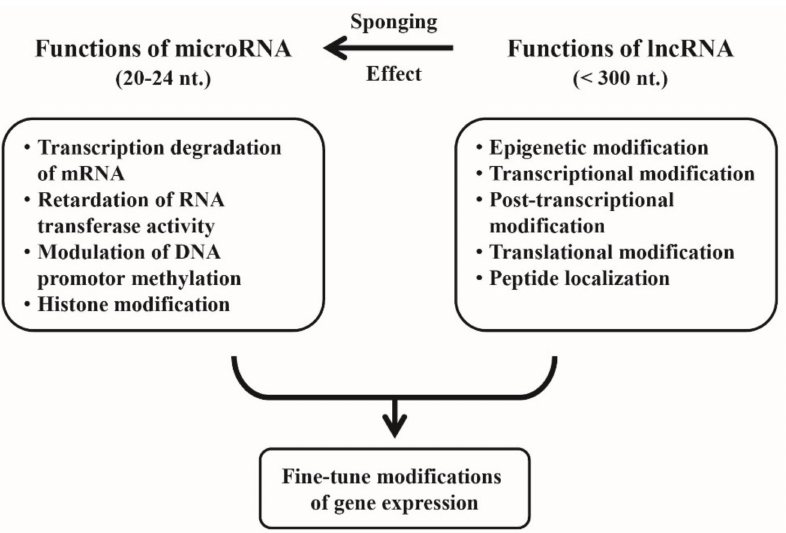
Figure 2. The individual functions of microRNAs (miRs) and long non-coding RNAs (lncRNAs), and their cross-talk for fine-tune regulation of the gene expression. The larger molecule of lncRNAs not only exhibit their own specific epigenetic regulatory power but act as sponges to modulate specific miR’s functions for achieving the fine-tune modifications of the gene